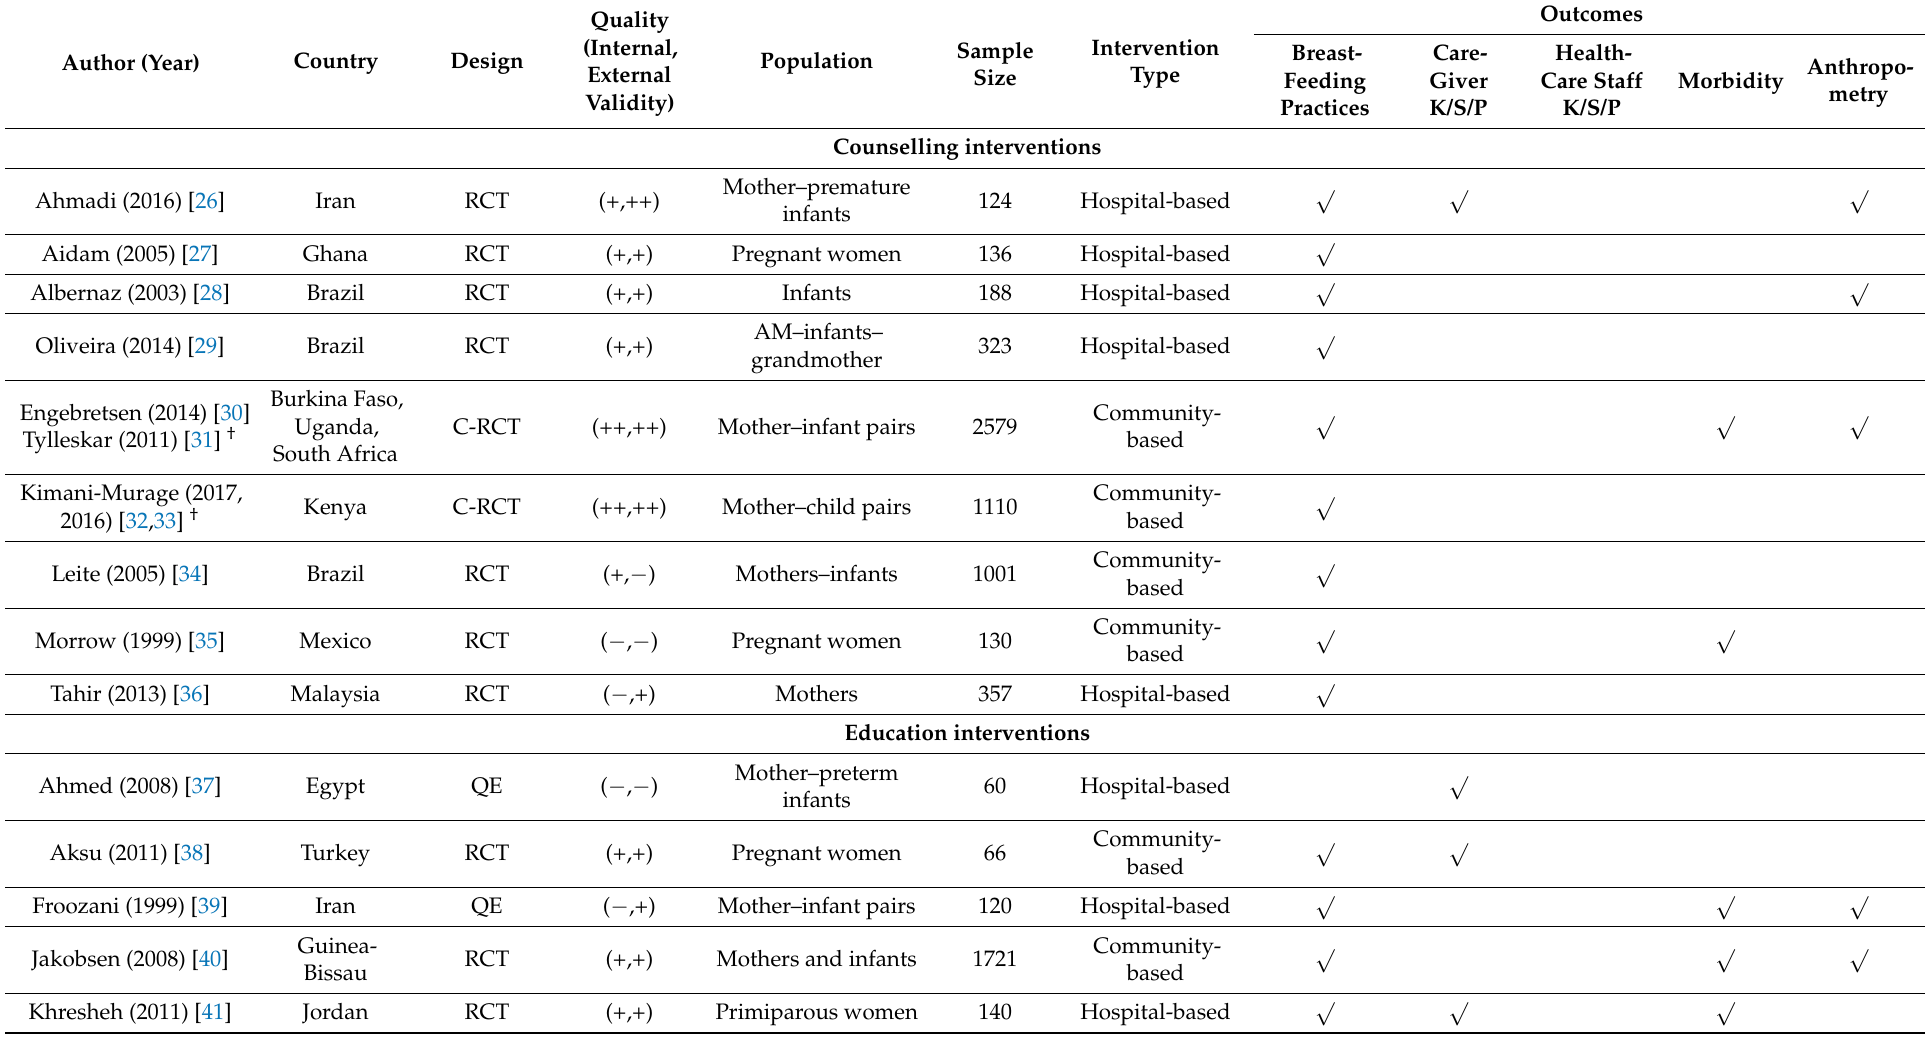
Table 1. Key characteristics of included studies, n =